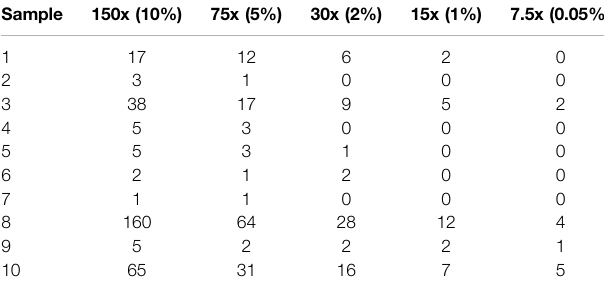
TABLE 4 | Fuseq-WES detection results (in terms of the number of supporting reads) for TMPRSS2-ERG fusion in 10 ProBio samples. For each ProBio sample, we obtained random subsamples of the reads of the original data at various lower-coverage